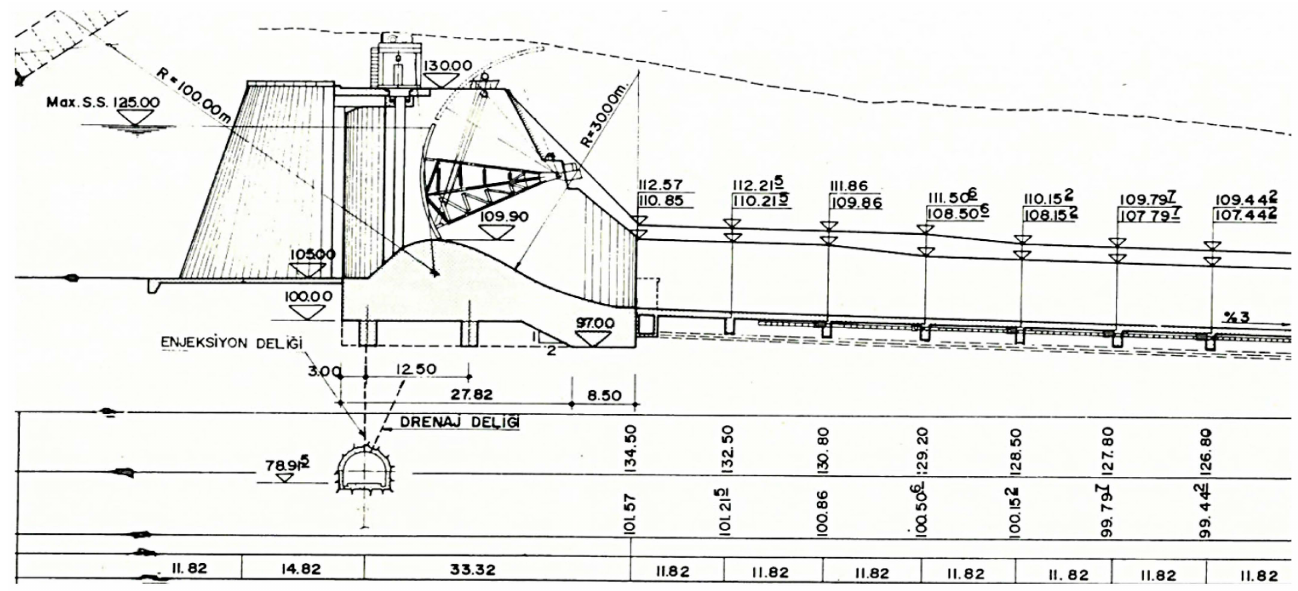
Figure 2. Section of the Çatalan Dam spillway structure (flow inlet part) [29].